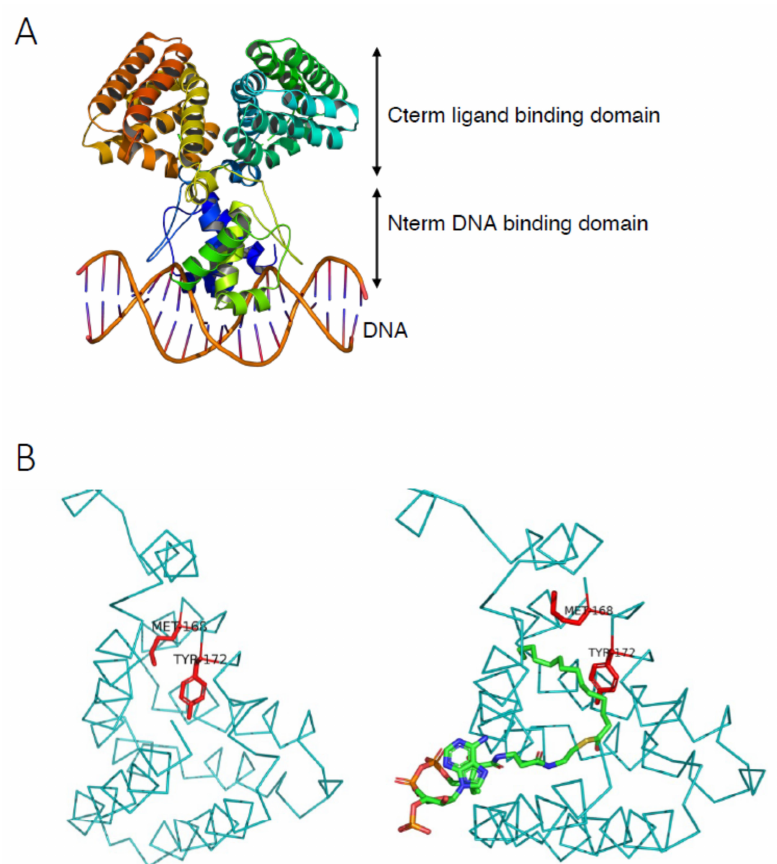
Figure 11. Structure of the FadR regulator. ( A ) Apo-FadR dimer bound to the DNA operator. PBD ID: 1H9T. ( B ) Close-up of the ligand binding domain. Apo-FadR on the left (PBD ID: 1E2X) and myristoyl-CoA bound on the right (PBD ID: 1H9G). The methionine 168 and tyrosine 172 residues are indicated in red, to highlight their movement upon ligand binding